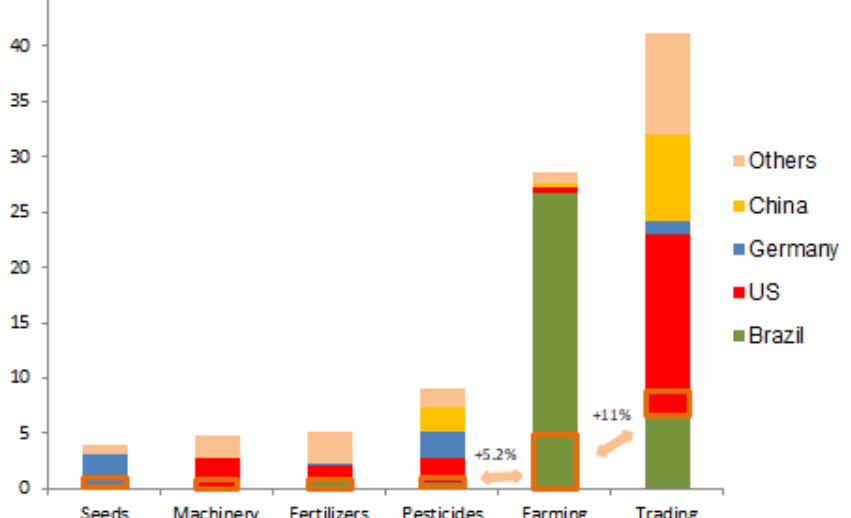
Figure 4. Market size of key segments of the soybean supply chain for the agricultural year of 2019/2020 and possible financial trade-offs between farming expansion and increasing market share in industrial segments (in USD billions). Source: Based on data published by Anprosem [36], Anda [37], Santos and Glass [49] and Escher and Wilkinson